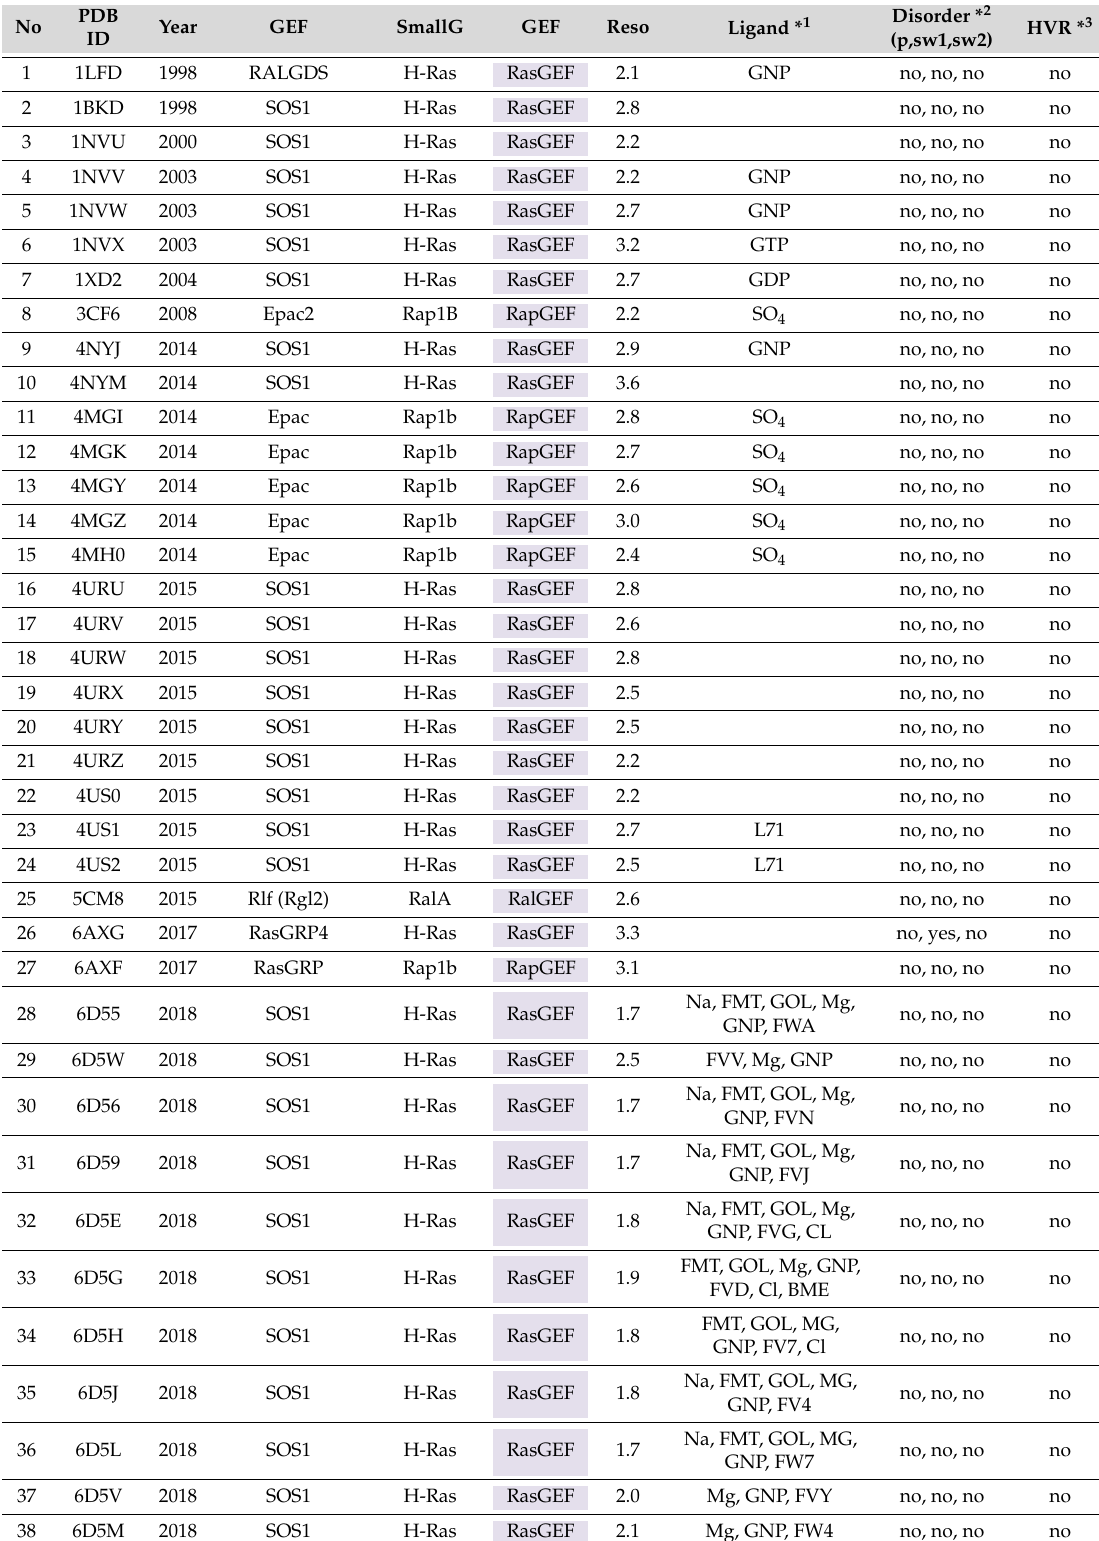
Table 1. GEF:Small GTPase